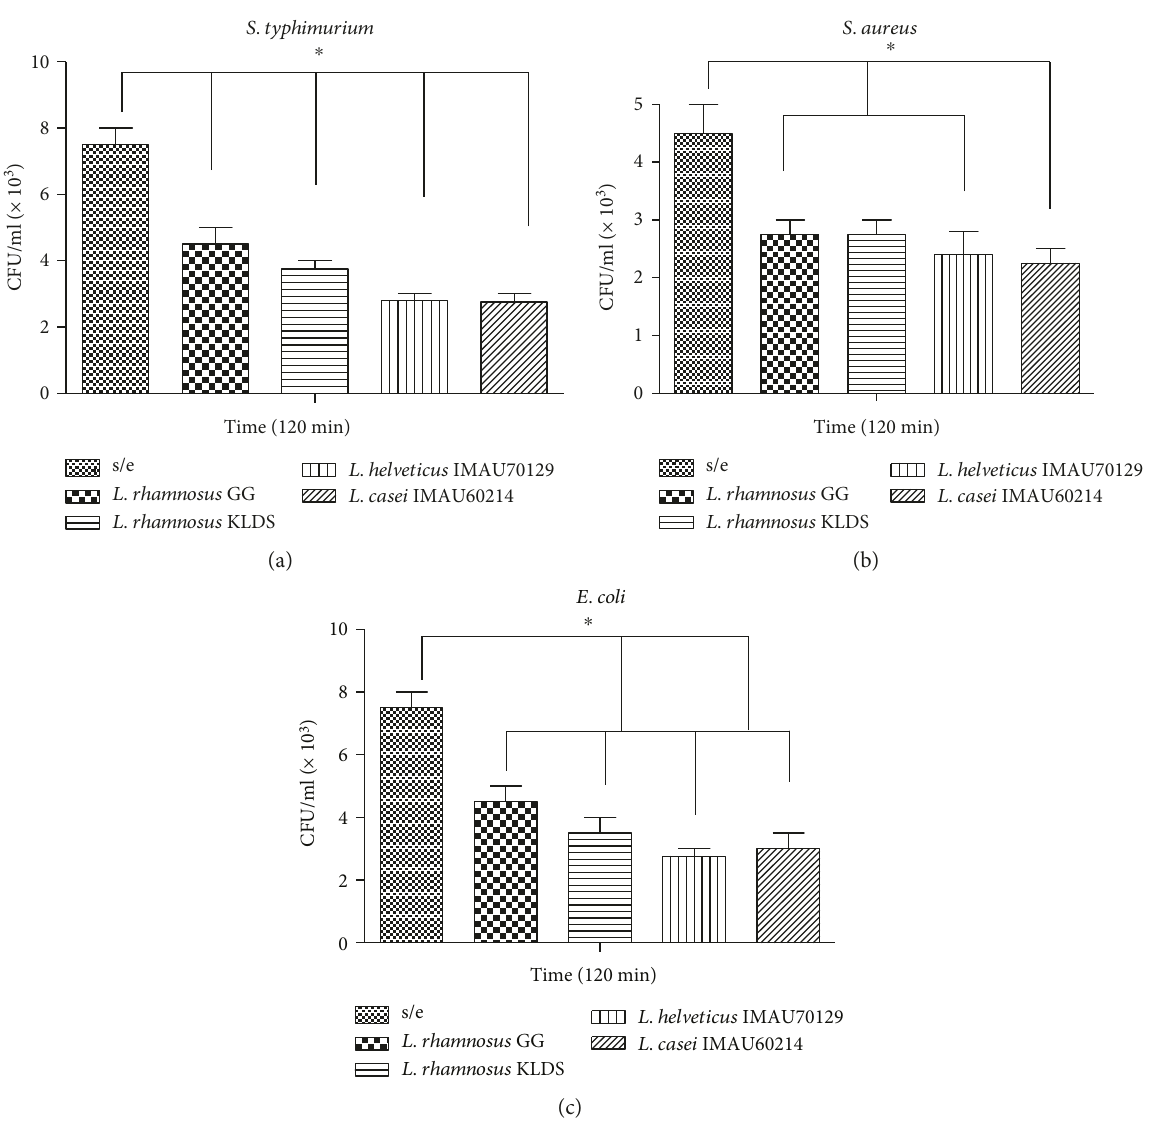
Figure 4: E ff ect of lactobacillus on the bacterial activity of macrophages against the pathogens S. typhimurium, S. aureus , and E. coli . Human macrophages were infected with (a) S. typhimurium , (b) S. aureus , or (c) E. coli and then incubated for 90min at 37 ° C to allow the bacteria to be internalized. External bacteria were then killed by applying gentamicin for 30 min at 37 ° C. Samples were taken immediately before gentamicin treatment (0 h) and every 120 min thereafter to determine viable counts following Triton X-100 lysis. The results are expressed as CFU per milliliter with means ± SD from no fewer than four separate experiments that were performed in duplicate using macrophages obtained from di ff erent human donors. Asterisks indicate a signi fi cant di ff erence between conditions ( p < 0 05